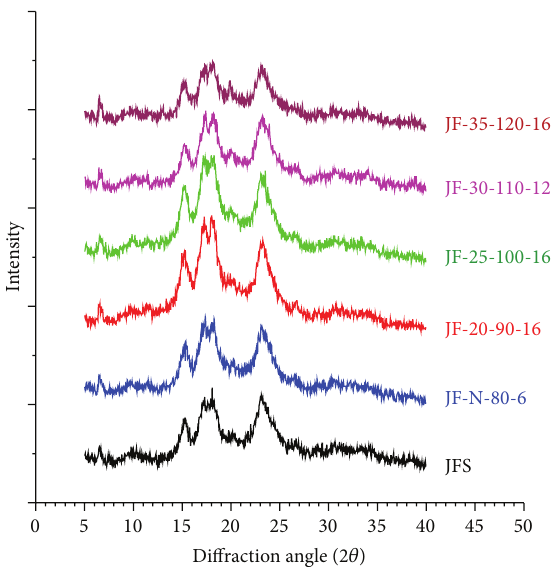
Figure 4: X-ray diffractograms of native JFS and five representative